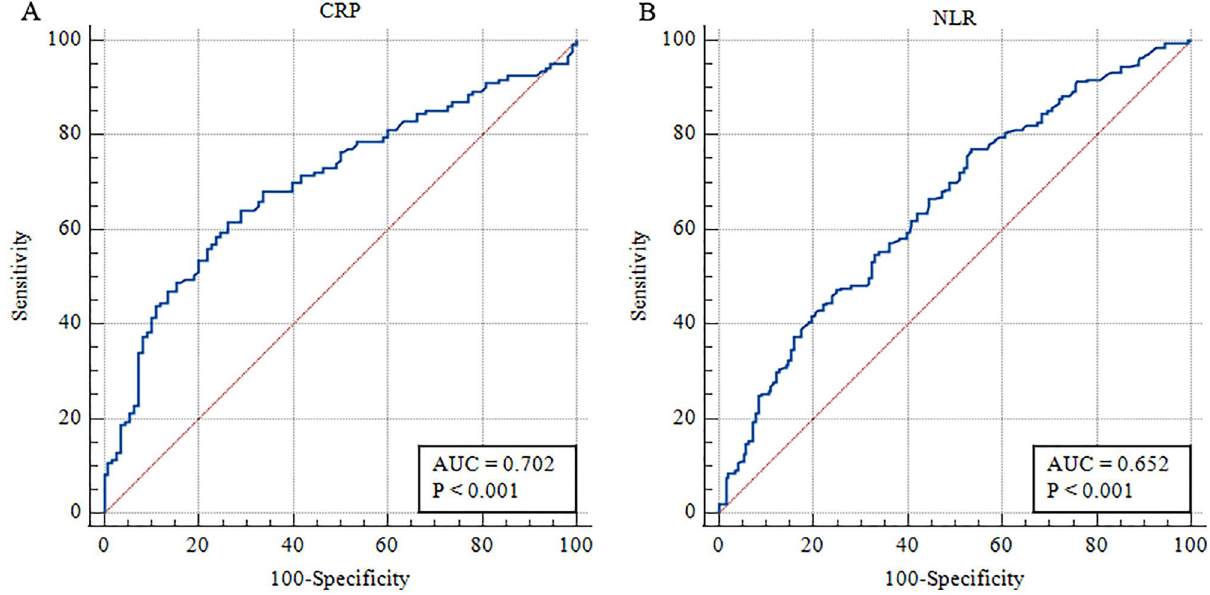
Figure 2. Optimal thresholds of C-reactive protein (CRP) and neutrophil to lymphocyte ratio (NLR) for predicting ST-segment resolution (STR) < 70%. ( A ) ROC curve of STR < 70% predicted by CRP; ( B ) ROC curve of STR < 70% predicted by NLR. AUC: area under the ROC